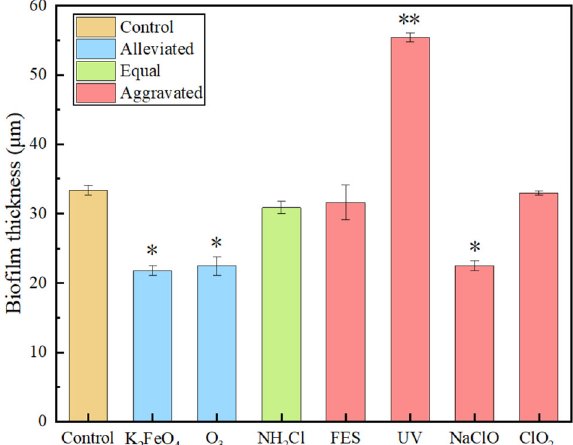
Fig. 3 Thickness of DRB bio fi lms (32 days). The thickness of bio fi lms were measured with laser scanning confocal microscope (LSCM). Ten points were randomly taken and averaged. Error bars represent the standard deviation for each independent experi- ments. The p value was generated by t test (* p < 0.05, ** p <